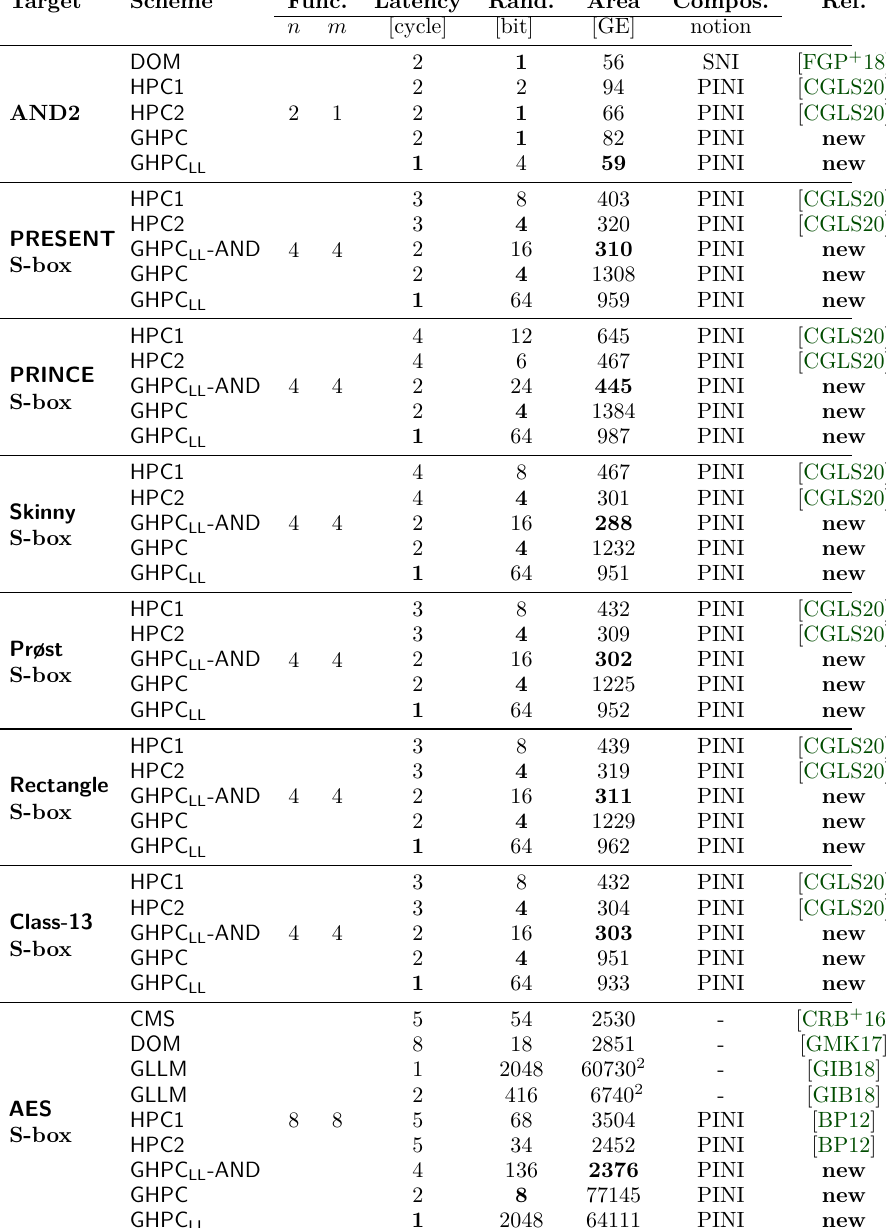
Table 1: Comparison of different first-order masking schemes. (using Synopsis Design Compiler and UMC 180 standard cell